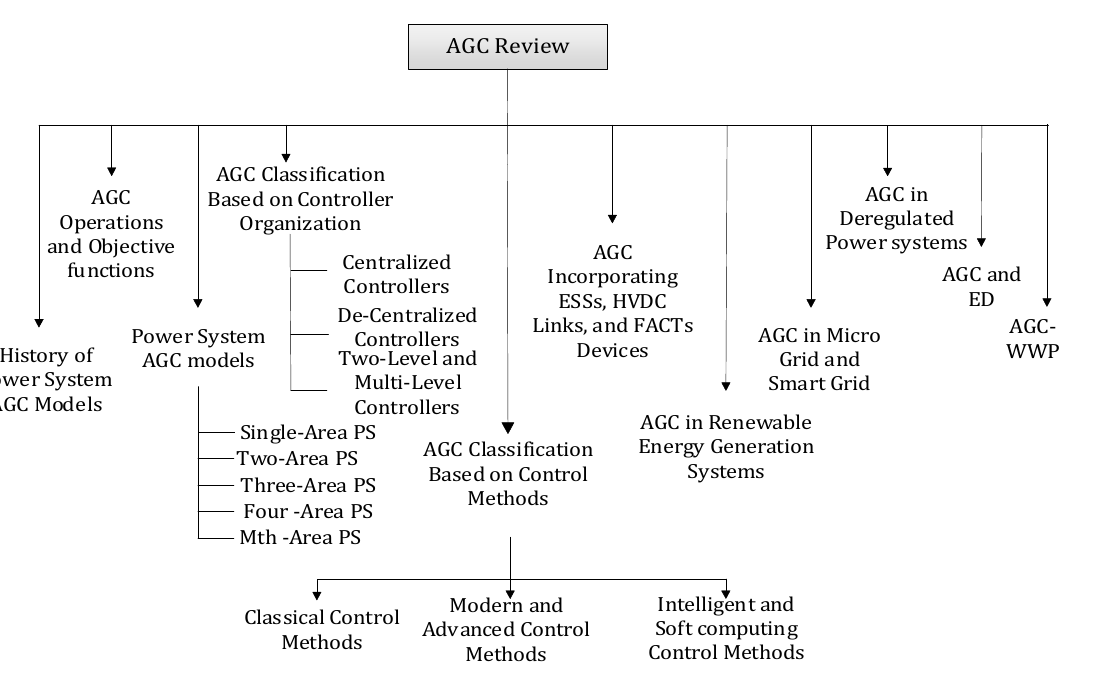
Figure 1. Structure of the survey.